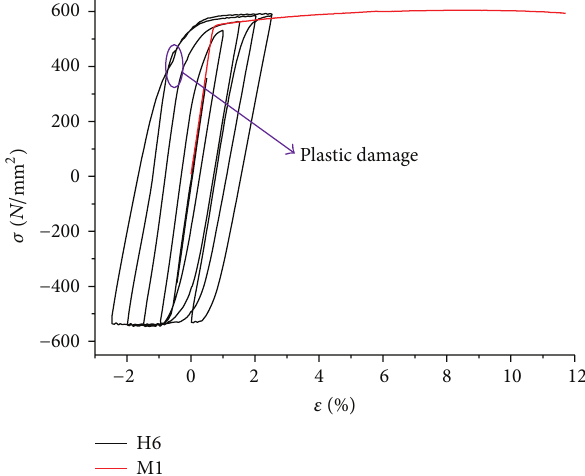
Figure 5: Comparison between monotonic and cyclic loading